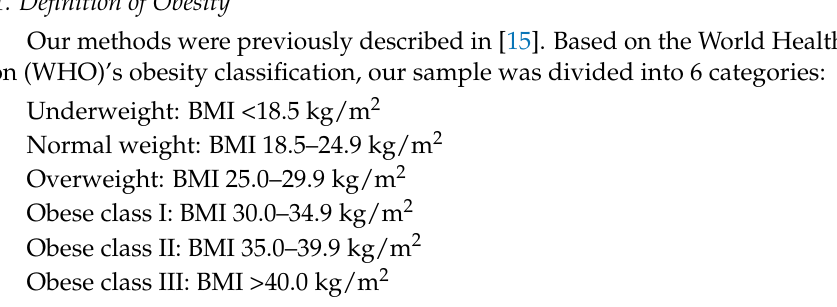
Figure 1. Patient selection and group distribution according to BMI classes.